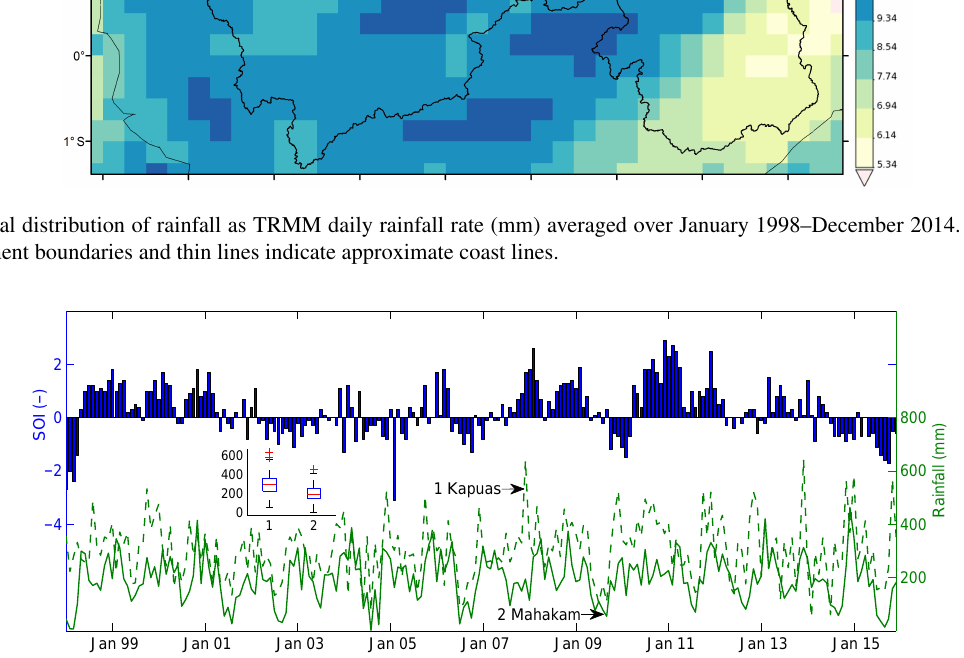
wetlands in March 2014 (Fig. 2, bottom right).